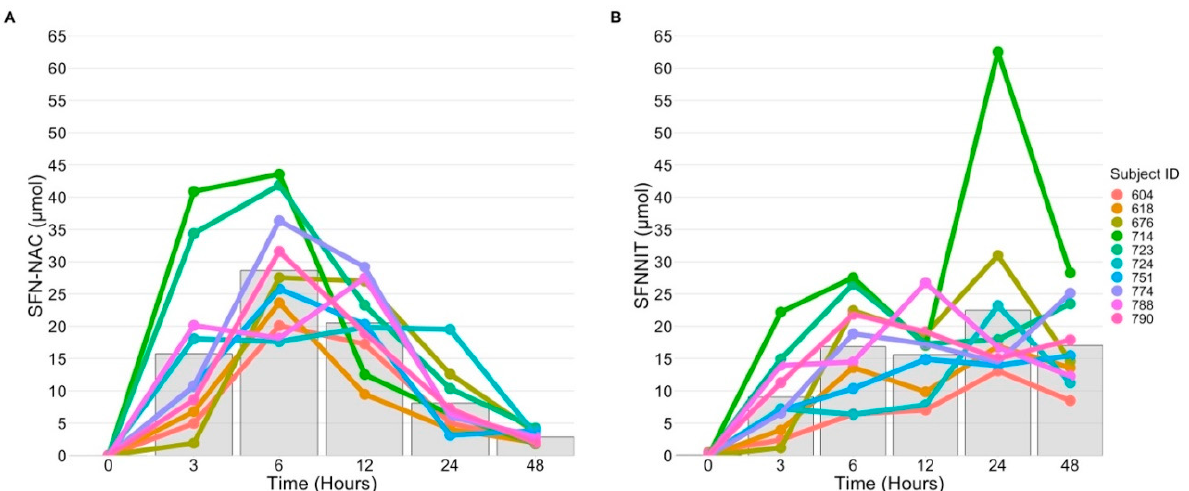
Figure 4. ( A ) Sulforaphane-N-acetyl cysteine (SFN-NAC) and ( B ) sulforaphane nitrile (SFN-NIT) detected in human urine following consumption of ~200 µ mol SFN equivalents in fresh broccoli sprouts directly following the 0 h time point. Colored dots represent levels of SFN metabolites in each individual subject and solid bars represent mean mass of metabolites excreted ( n = 10).